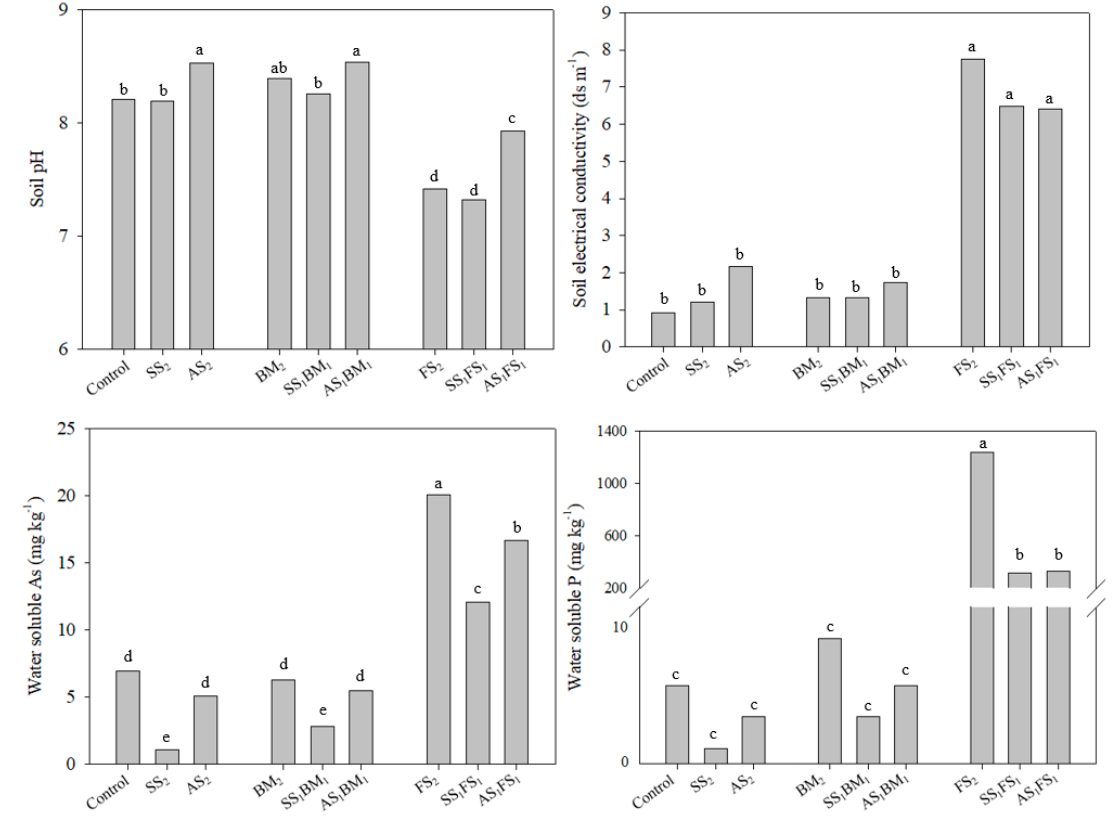
Figure 1. Chemical characteristics of soil under the different treatments. Different letters indicate significant differences at the 5% level according to Duncan’s test. The treatment combinations are listed in Table 1; SS 2 , steel slag (SS) 2%; AS 2 , acid mine drainage sludge (AMDS) 2%; BM 2 , bone meal (BM) 2%, FS 2 , fused superphosphate (FS) 2%; SS 1 BM 1 , SS 1% + BM 1%; SS 1 FS 1 , SS 1% + FS 1%; AS 1 BM 1 , AMDS 1% + BM 1%; and AS 1 FS 1 , AMDS 1% + FS 1%.